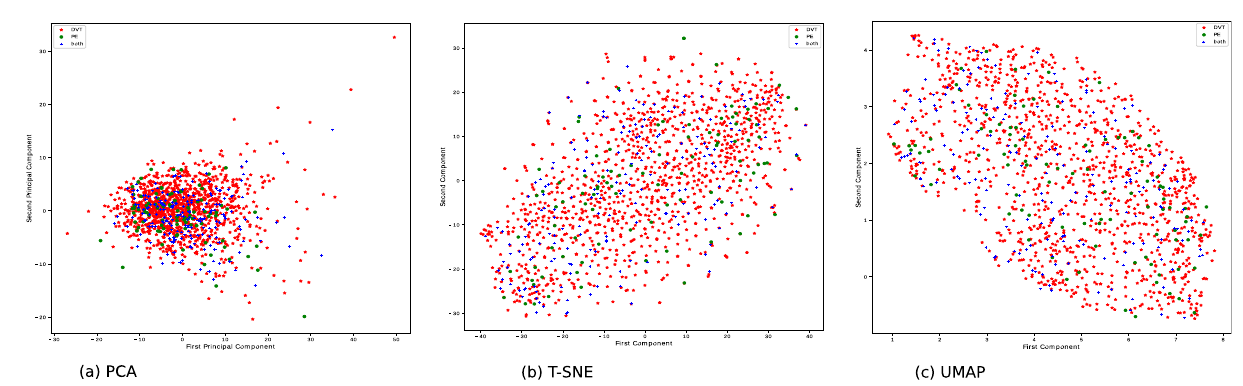
Figure 2. Graphical representation of the HPAs and biological MARTHA data projected on the first two principal components derived from standard principal components analysis ( a ), t-SNE ( b ) and UMAP ( c )